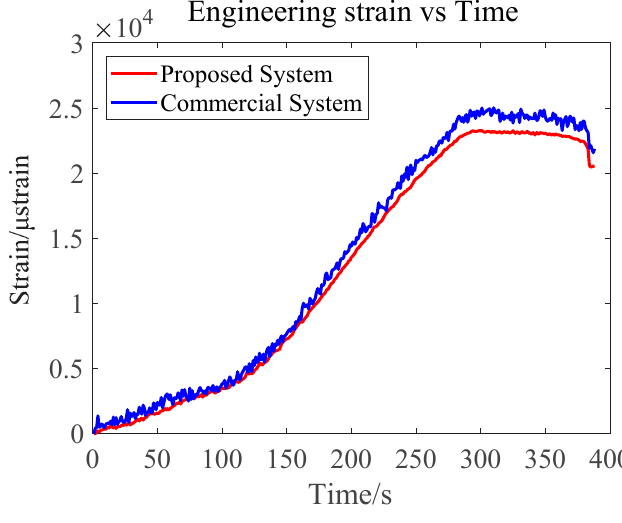
Figure 13. Engineering strain curve.